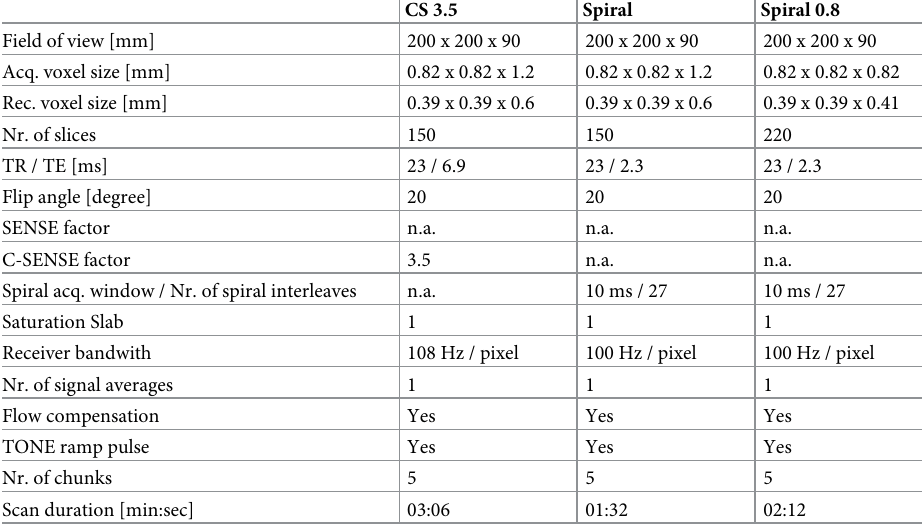
Table 1. Sequence parameters of the TOF MRA